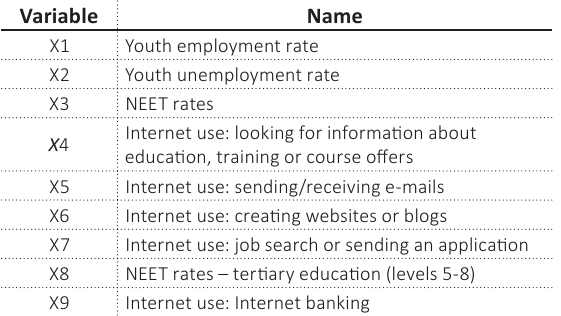
Table 2. The characteristics of the selected variables describing the conditions of the youth at the age of 15-29 in the labor market Source: Authors’ elaboration.